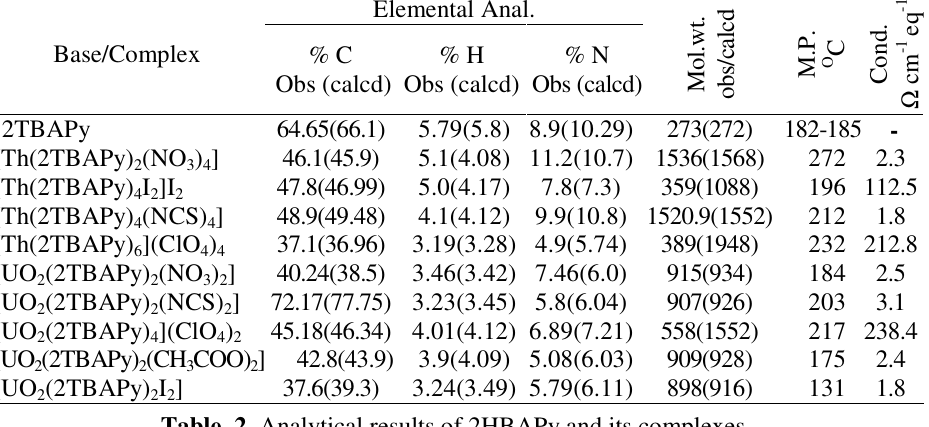
Table 1. Analytical results of 2-TBAPy and its complexes. Elemental Anal.